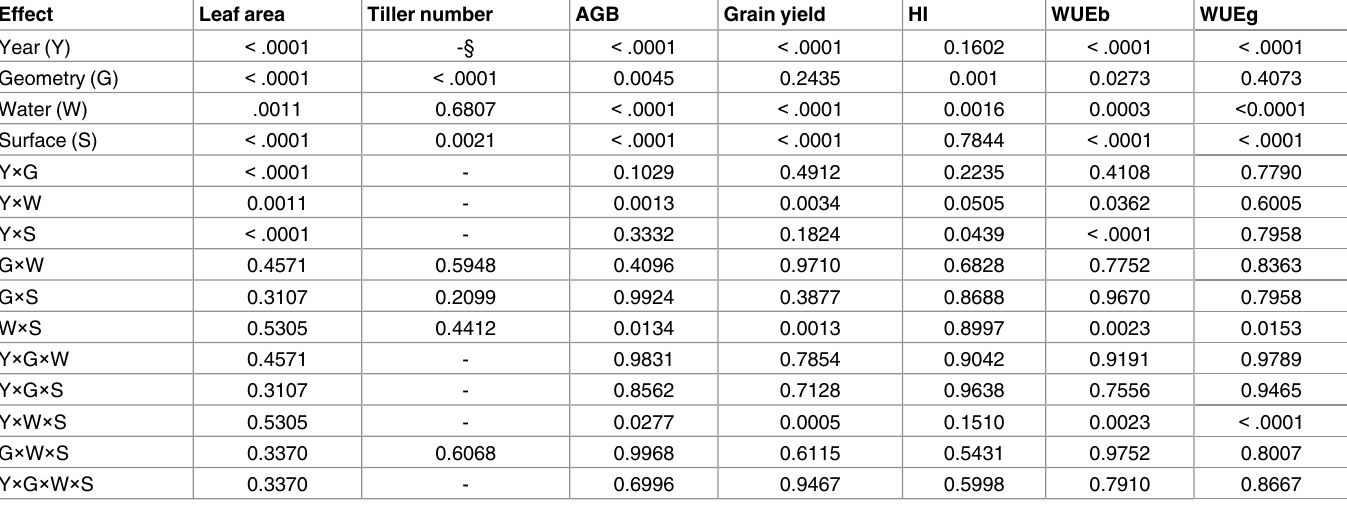
Table 1. P-values of sorghum leaf area, tiller number, aboveground biomass (AGB), grain yield, harvest index (HI), biomass water use efficiency (WUEb), and grain water use efficiency (WUEg) as affected by year, geometry, water, and soil surface as determined by analysis of variance (ANOVA).